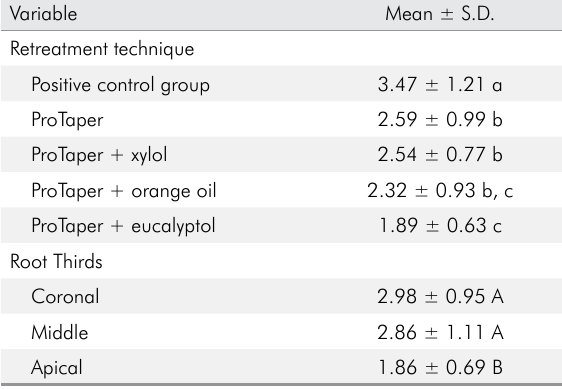
Table 1. Means and standard deviations of bond strength (in MPa) for displacement of the sealer from the specimens after reobturation according to the retreatment techniques and root canal